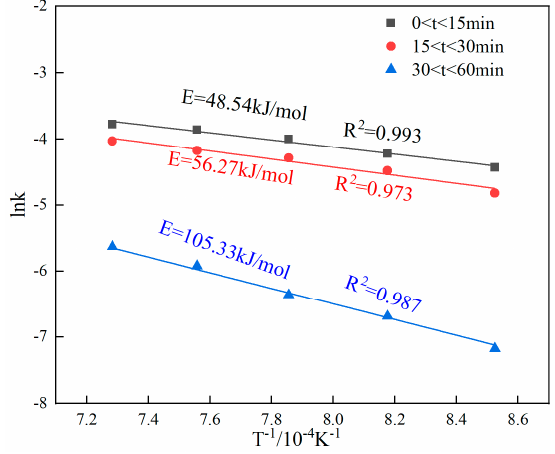
Figure 10. Linear fitting curves of the relationship between ln k and 1/ T.